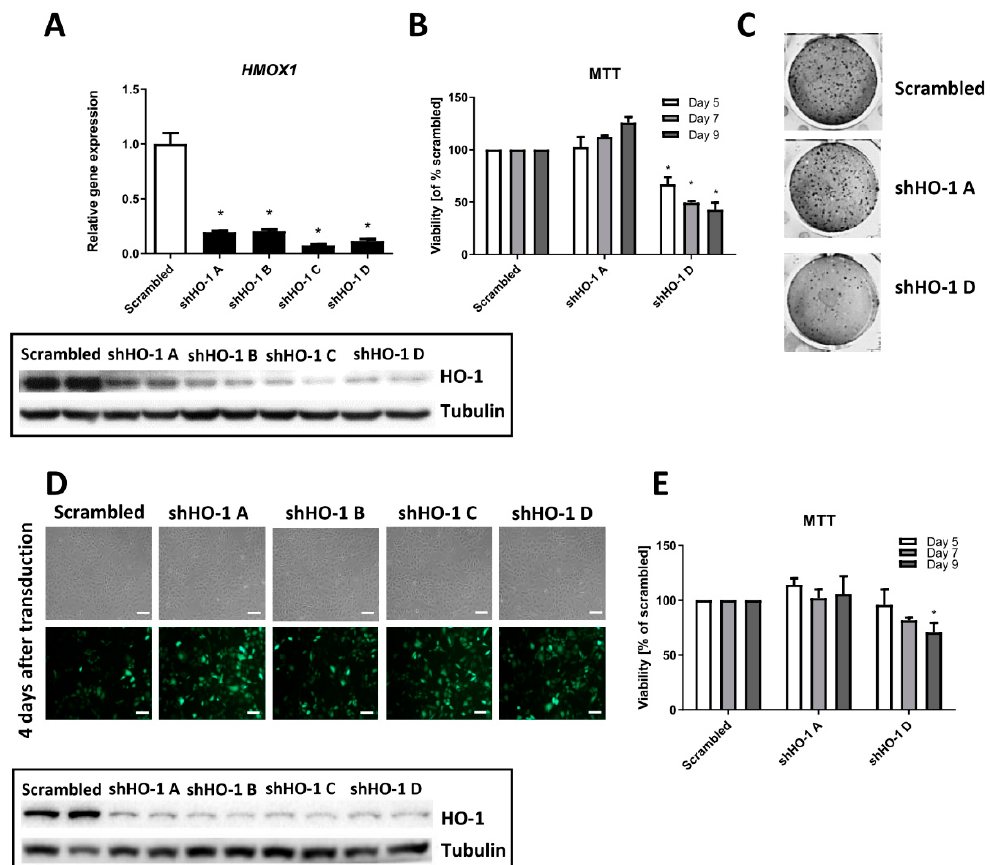
Figure 4. Genetic inhibition of HMOX1 in the NCCFH1 and UOK 268 cell lines exert similar effects as in UOK 262 cells. FH-deficient cell lines were transduced with lentiviral vectors encoding four shRNA sequences against HMOX1 transcript and with one, non-specific scrambled shRNA. ( A ) qRT-PCR results of HMOX1 silencing level in NCCFH1 cell line after transduction with HO-1 shRNA sequences and scrambled shRNA presented as relative fold change (mean ± SD, upper panel); a representative picture of Western blot analysis of HO-1 after transduction (lower panel). ( B ) MTT viability assay on NCCFH1 cells after several time-points (5–9 days) from transduction, presented as the percentage of scrambled shRNA (mean ± SD). ( C ) Representative pictures of colony formation assay on the NCCFH1 cell line after 14 days after transduction with shHO-1. ( D ) Microscopic images of UOK268 cells both in the bright field (upper part) and under fluorescence (lower part) 4 days after transduction with lentiviral vectors encoding shHO-1 and scrambled; scale bar: 100 μ m. ( E ) MTT viability assay on